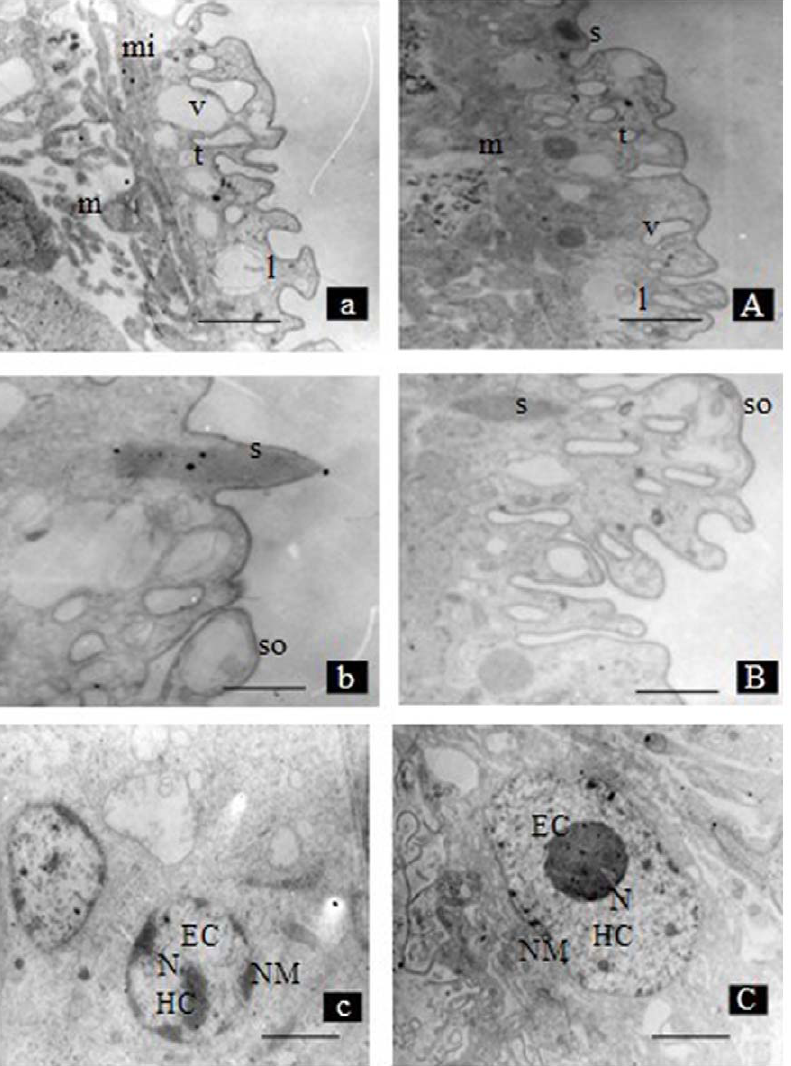
Figure 2. Ultrastructural differences in schistosomula from Microtusfortis (a, b, c) and BALB/c mice (A, B and C) evident by transmission electron microscopy (TEM): a/A Low magnification of the tegument region: muscle bundles (m); vesicles (v); tegument matrix (t); large bodies (l); mitochondria (mi). Bar =1 m m. b/B High magnification of the tegument region: surface spine (s); sensory organelle (so); Bar=500 nm. c/C Ultrastructure of a single cell: euchromatin (Ec); heterochromatin (Hc); nuclear membrane (NM); Bar=500 nm.